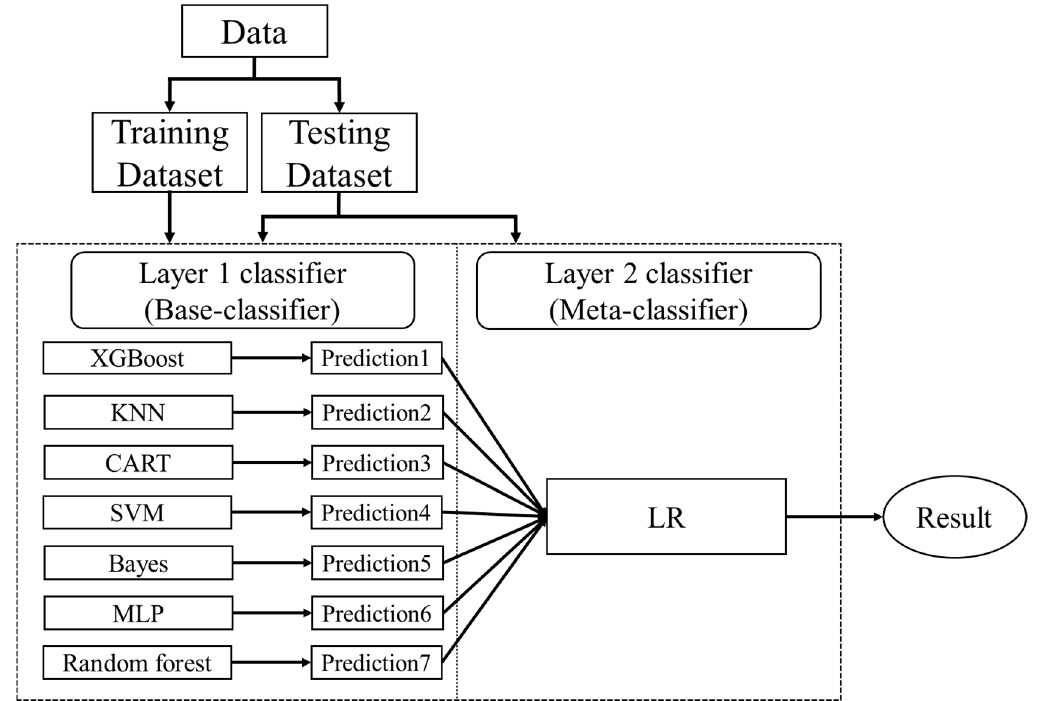
Figure 1. Stack ensemble learning model architecture.